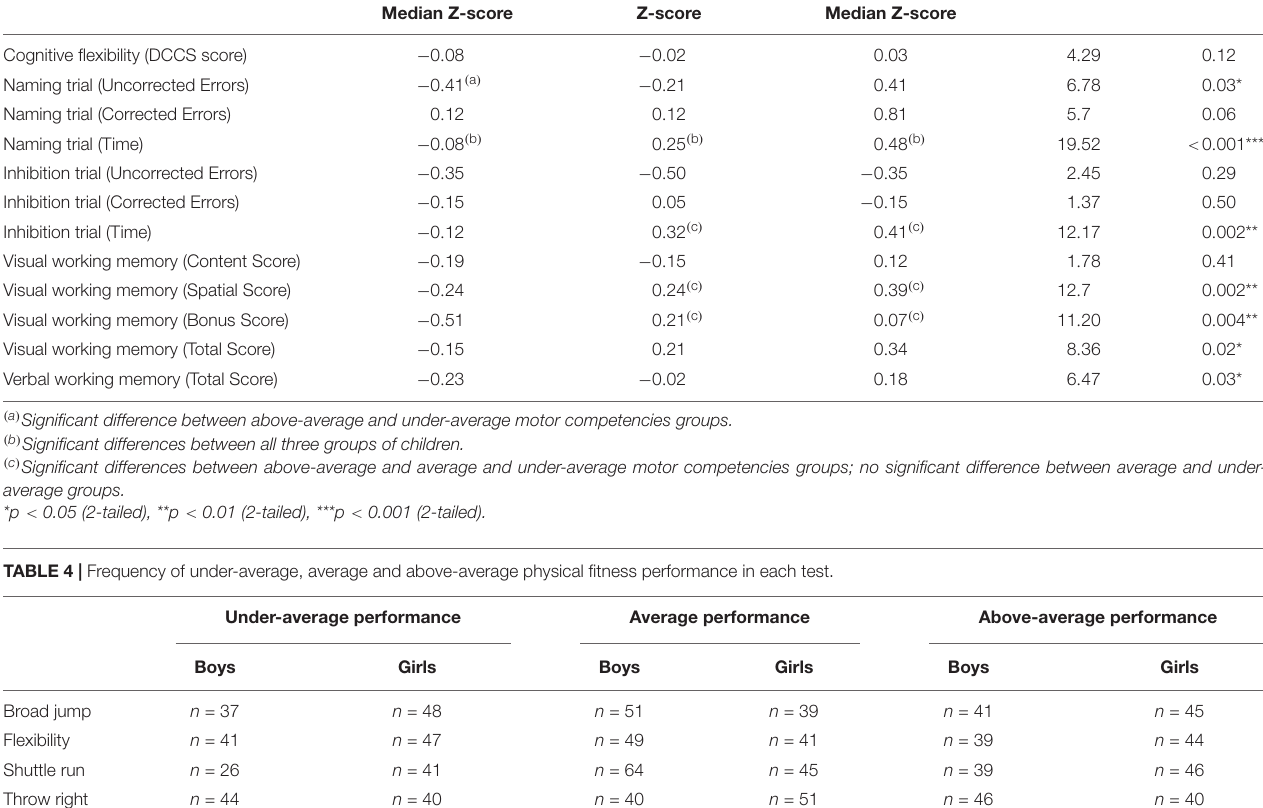
Under-average Average Median Median Z-score Z-score